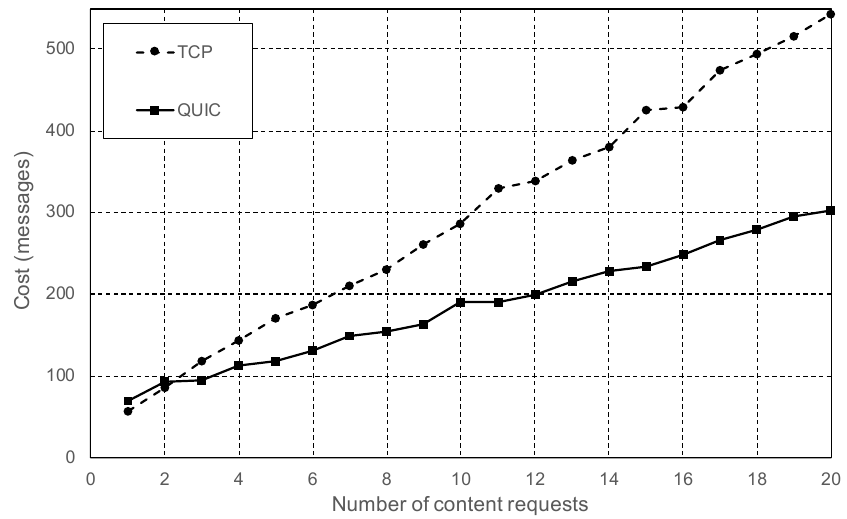
Figure 8. Total number of messages required to fetch content from another node, including the initial